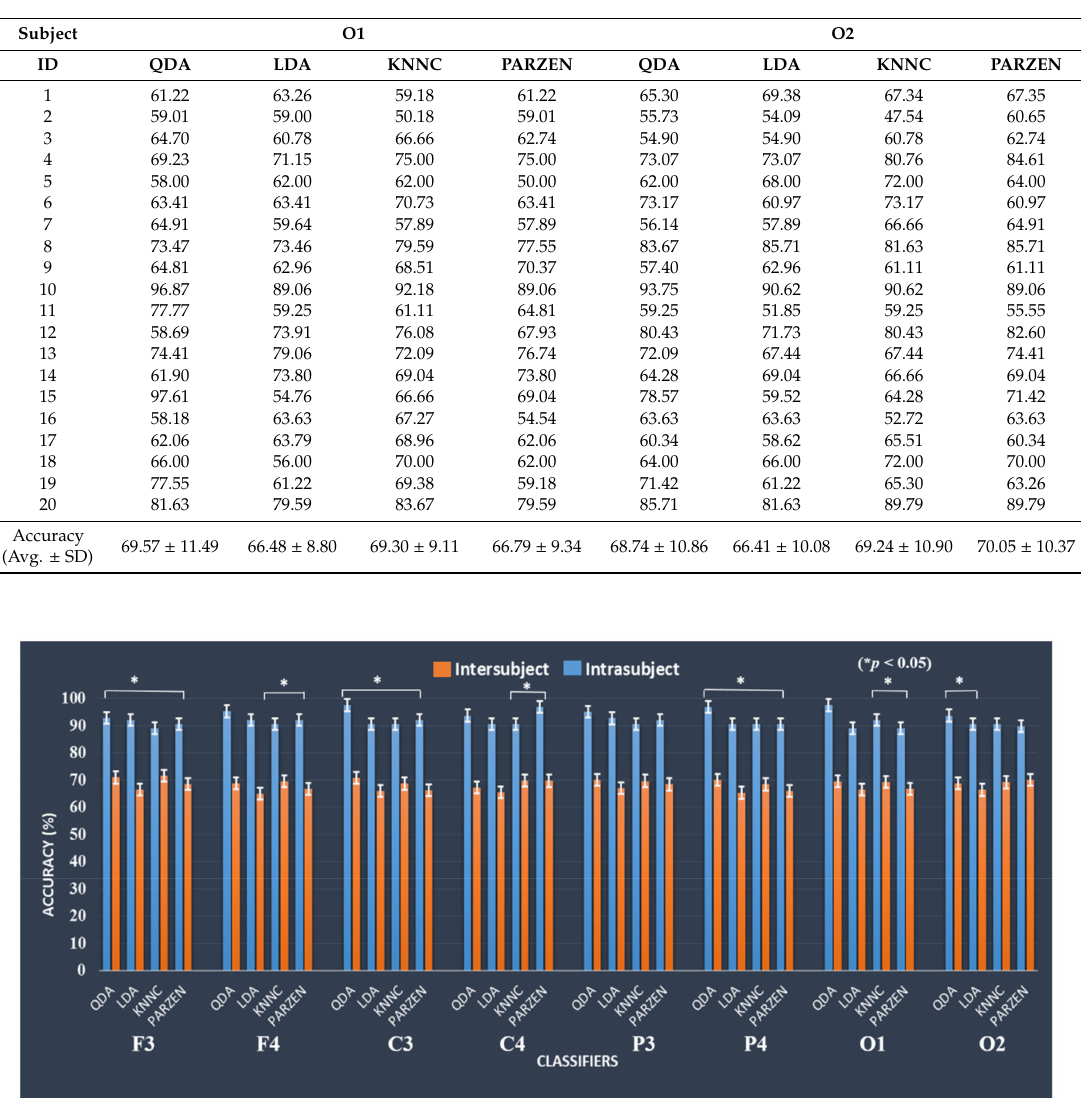
Table 5. Result of leave-one-out cross validation using the EEG frequency spectrum (1–50 Hz) as input in the machine learning approaches including QDA, LDA (parametric), KNNC and PARZEN (nonparametric). The performance of the classification system is compared in accuracy (%) during inter-subject and intra-subject variability in occipital lobe (O1 and O2) of the brain.